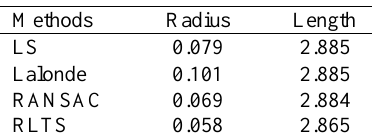
Table 4. Estimated radii (m) and lengths (m) of the fitted cylinders from different methods for signpost data